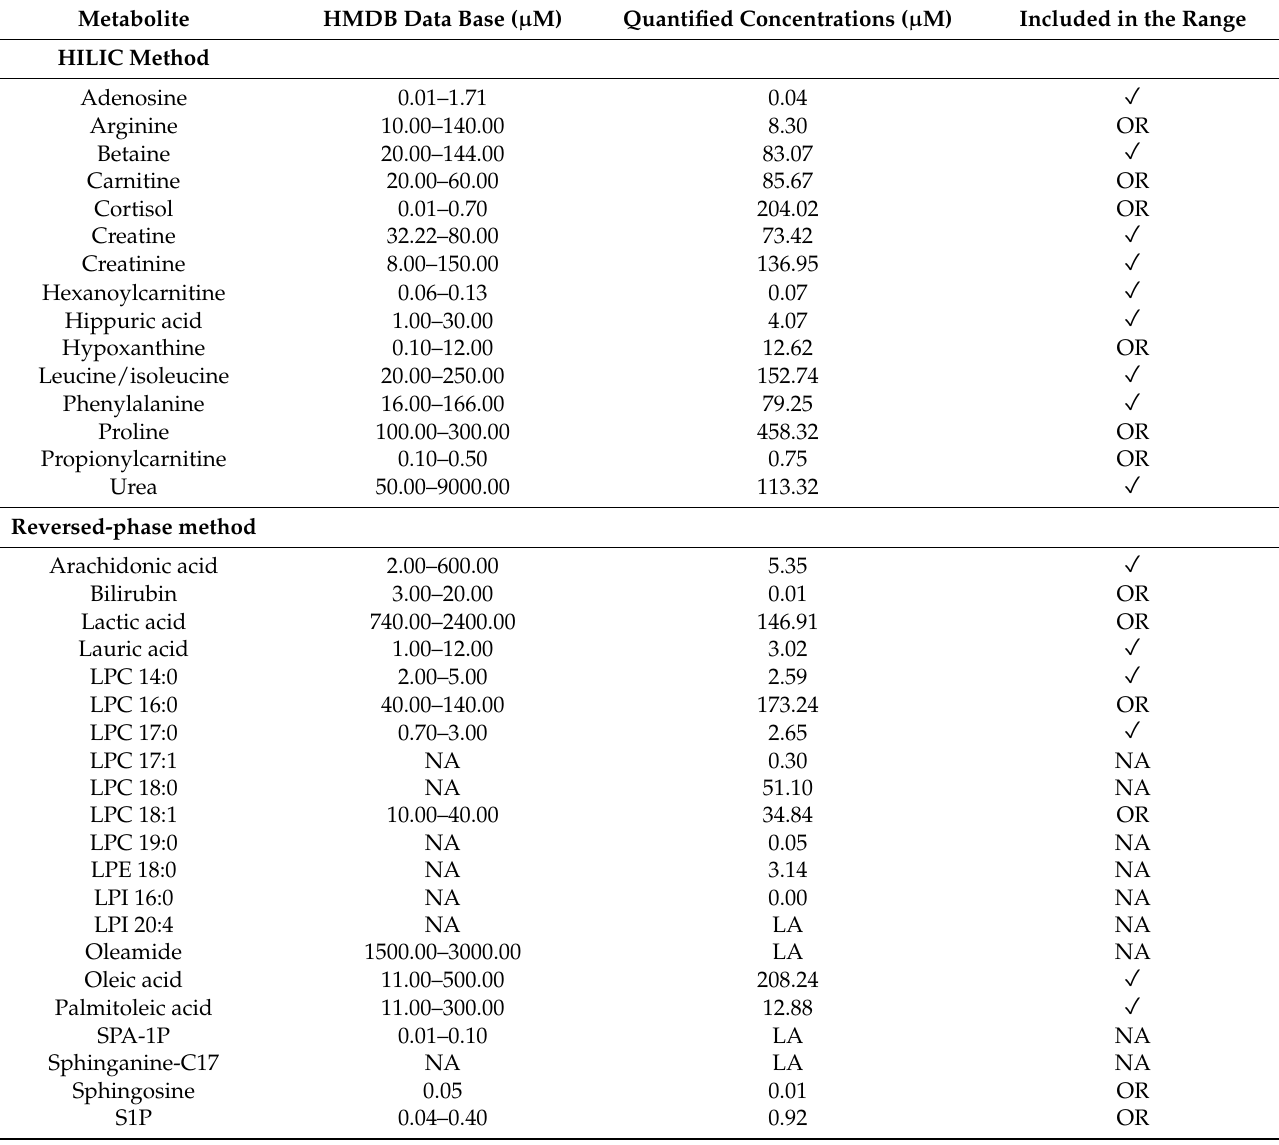
Table 4. Experimental and HMDB concentrations of the analyzed metabolites.